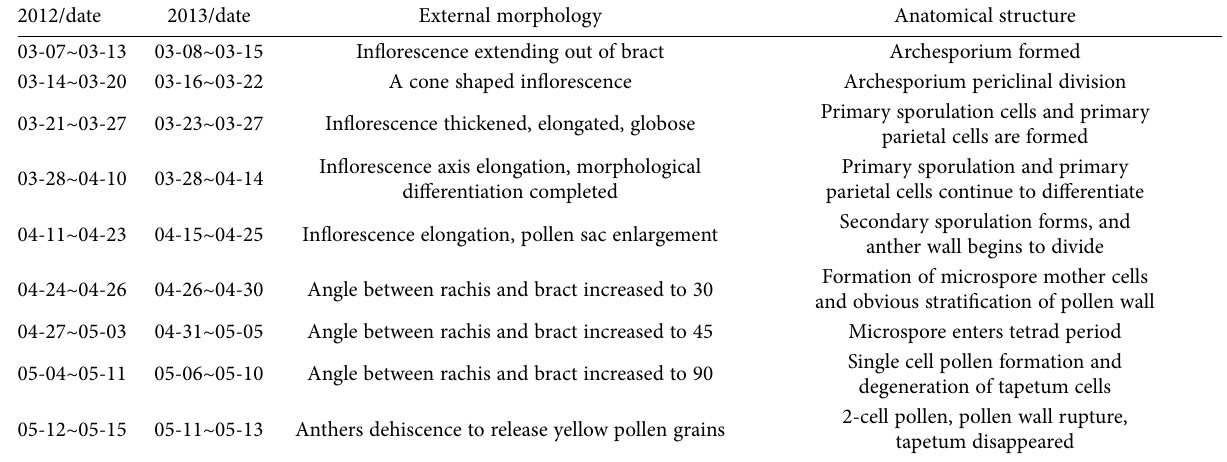
Table 1. Relationship between the external morphology and anatomical structure on staminate flora-bud development of Carya illinonensis